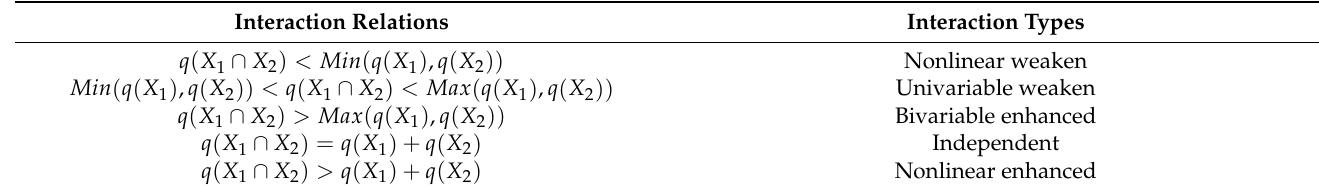
Table 2. Interaction detection